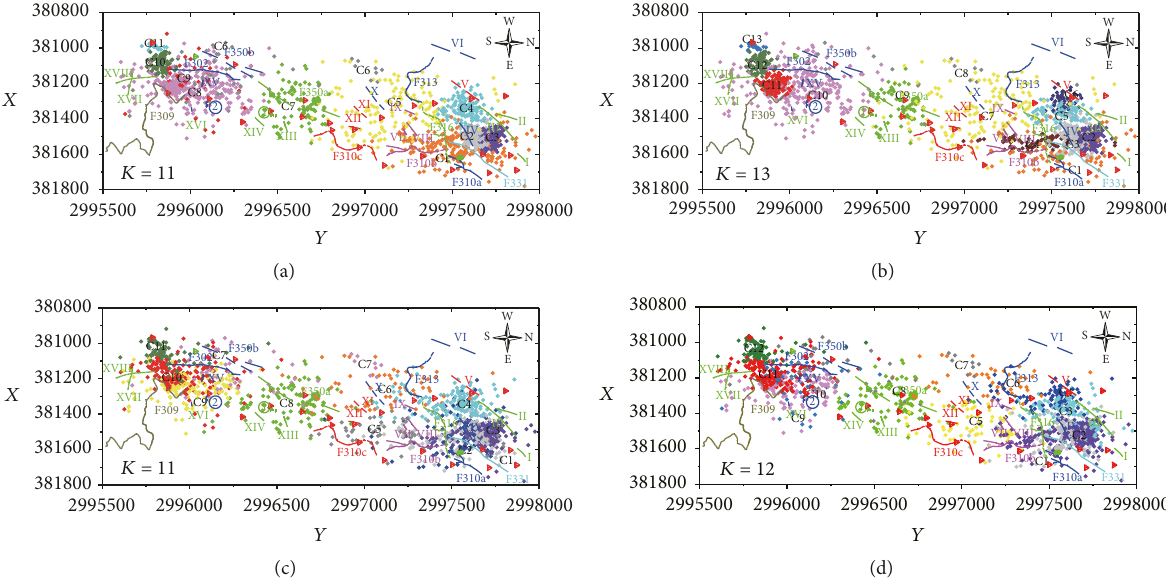
Figure 6: Cluster results of GMM and SOM with different cluster numbers. (a) and (b): 𝐾 = 11 and 𝐾 = 13 of GMM clusters; (c) and (d): 𝐾 = 11 and 𝐾 = 12 of SOM clusters. The solid lines represent determined faults, while the dashed lines represent inferred faults by mine geologists. The symbols A and B represent caves, and the triangles represent the location of